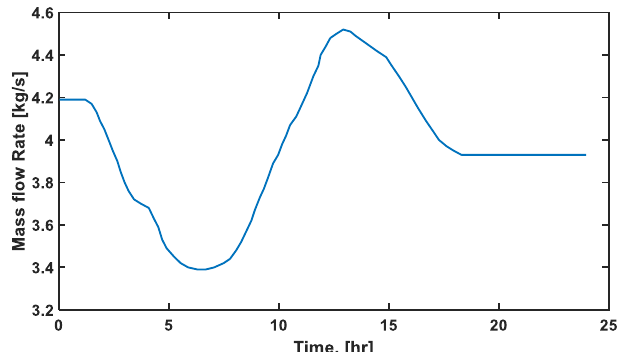
Figure 4. Mass flow rate changes at the outlet of the pipeline for validation test.